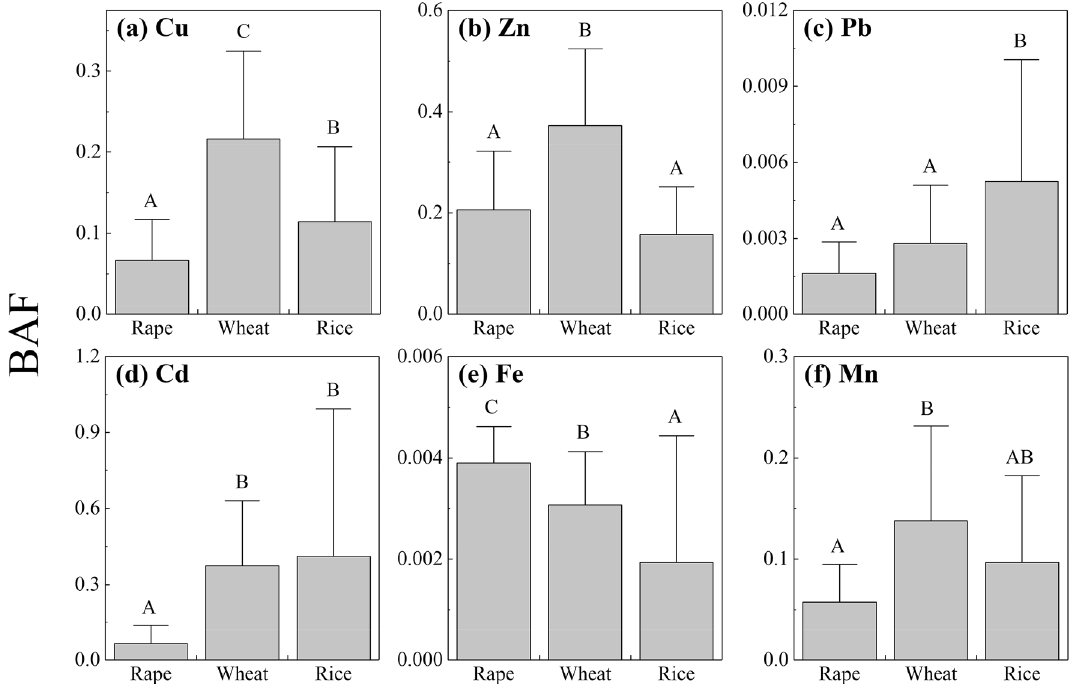
Figure 5. Bioaccumulation factors ( BAF ) of heavy metals ((a) Cu, (b) Zn, (c) Pb, (d) Cd, (e) Fe, and (f) Mn) from soil to the grains of three crop species. The error bars indicate the standard deviation. Different letters on bars indicate significant difference ( p < 0.05) between